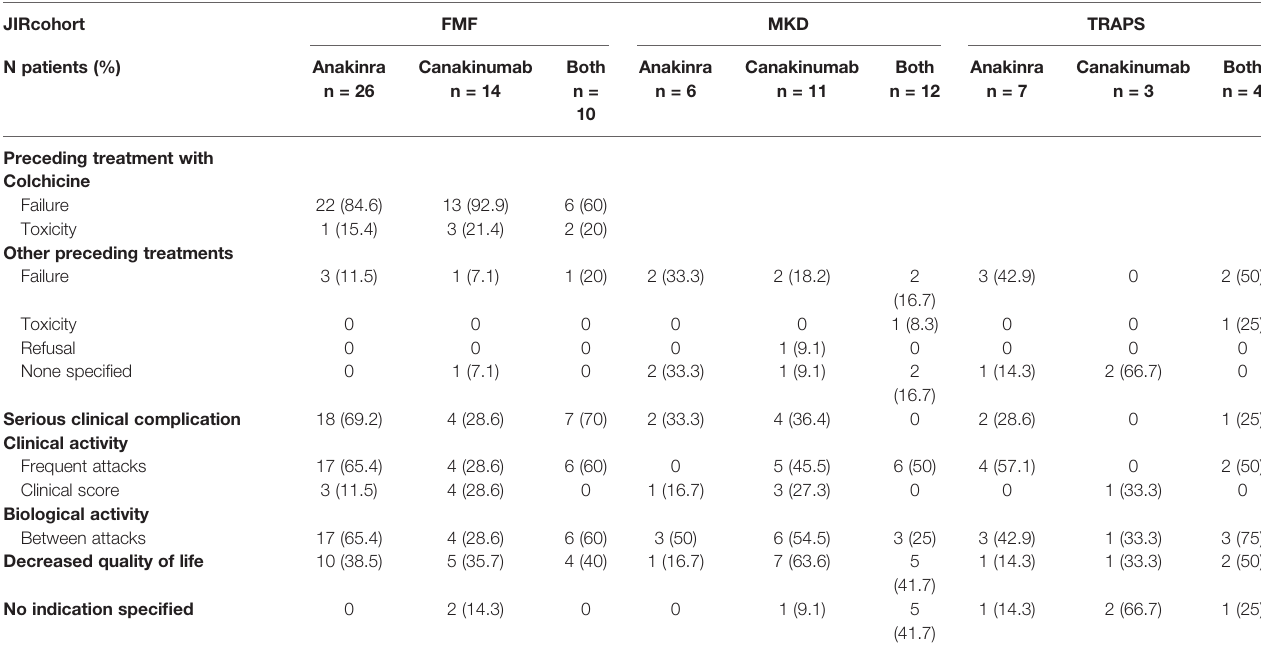
TABLE 2 | IL-1 blockers ’ indications: JIRcohort (population N = 73). IL, interleukin; FMF, familial Mediterranean fever; MKD, mevalonate kinase de fi ciency; TRAPS, tumor necrosis factor receptor-associated periodic syndrome. JIRcohort FMF MKD TRAPS N patients